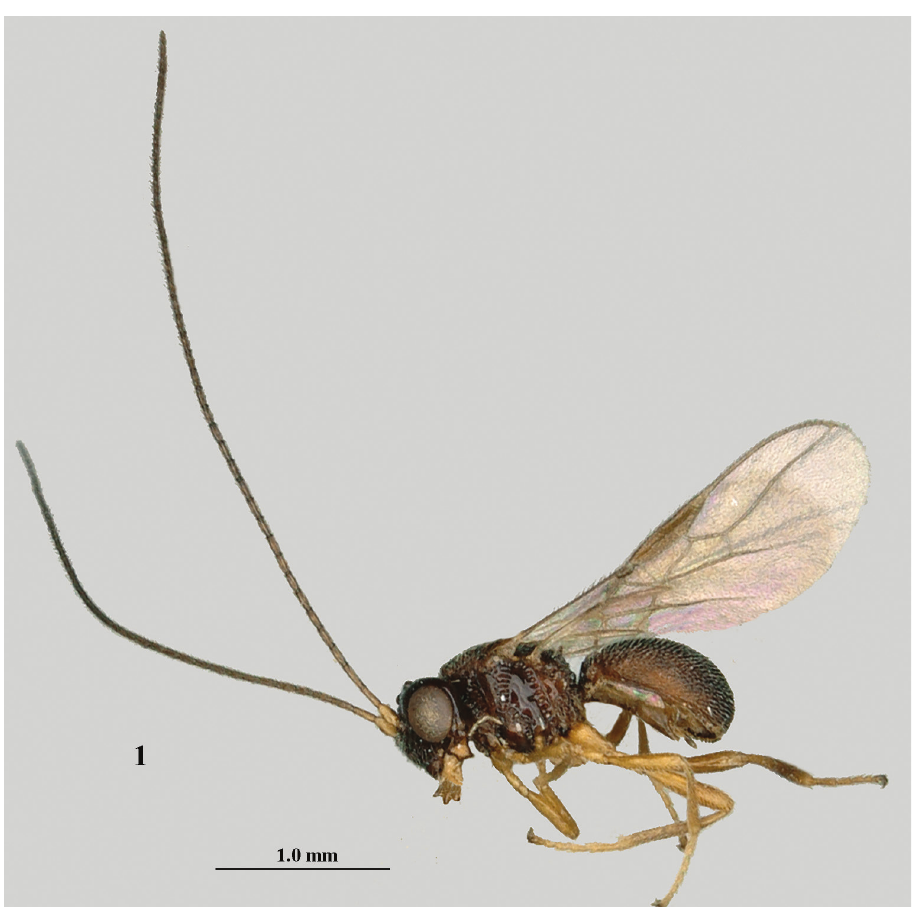
Figure 1. Gastralysia garambana Fischer, ♀ , Ivory Coast, habitus, lateral